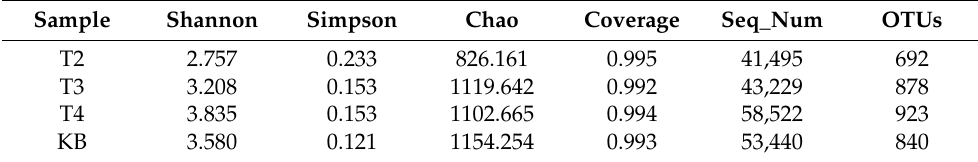
Table 3. Bacterial Alpha Diversity Index and Sequence Length